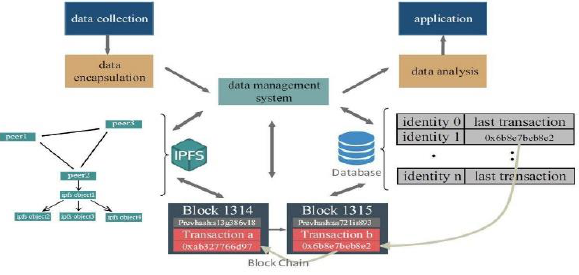
Fig. 3.3 A proposed model